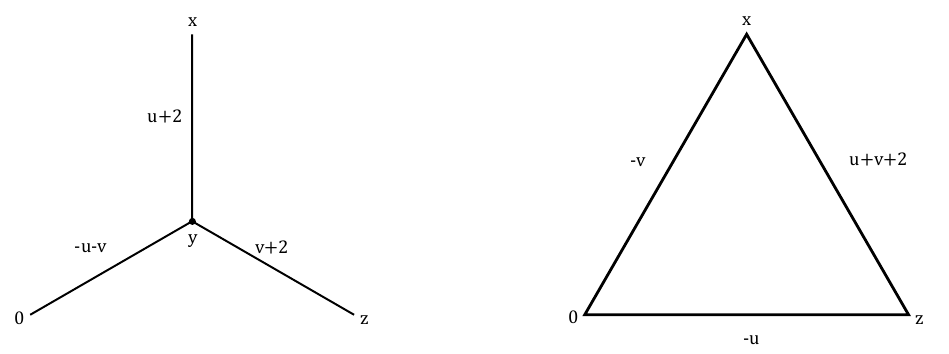
to the power written next to it, where x ij